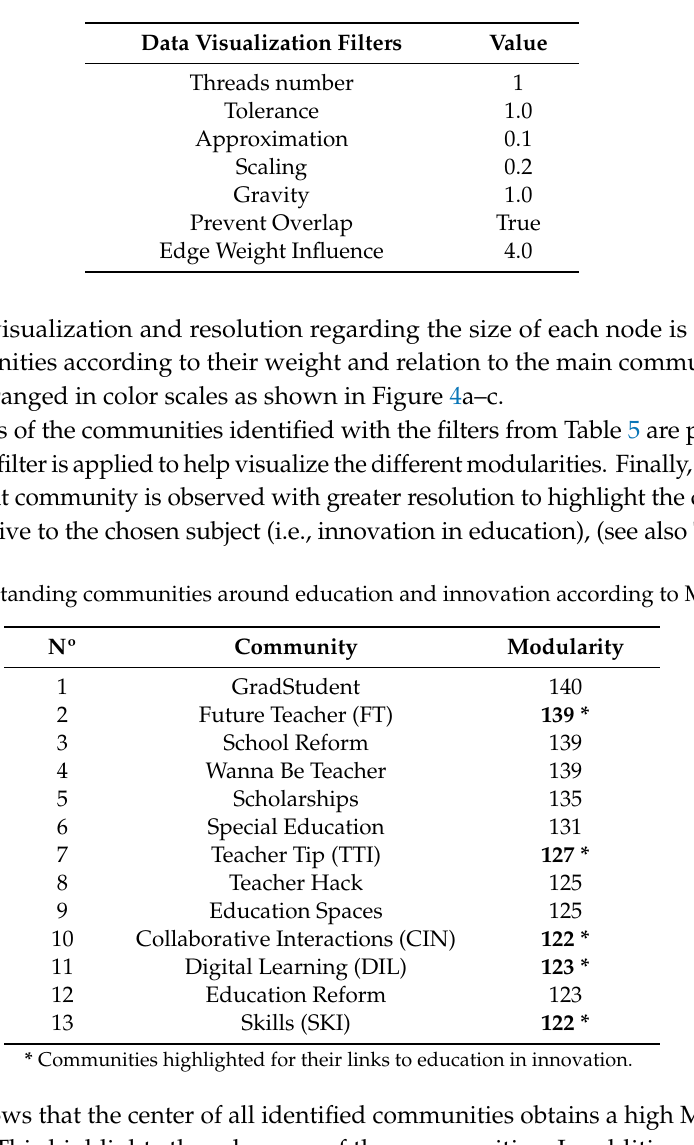
Table 5. Communities definition.